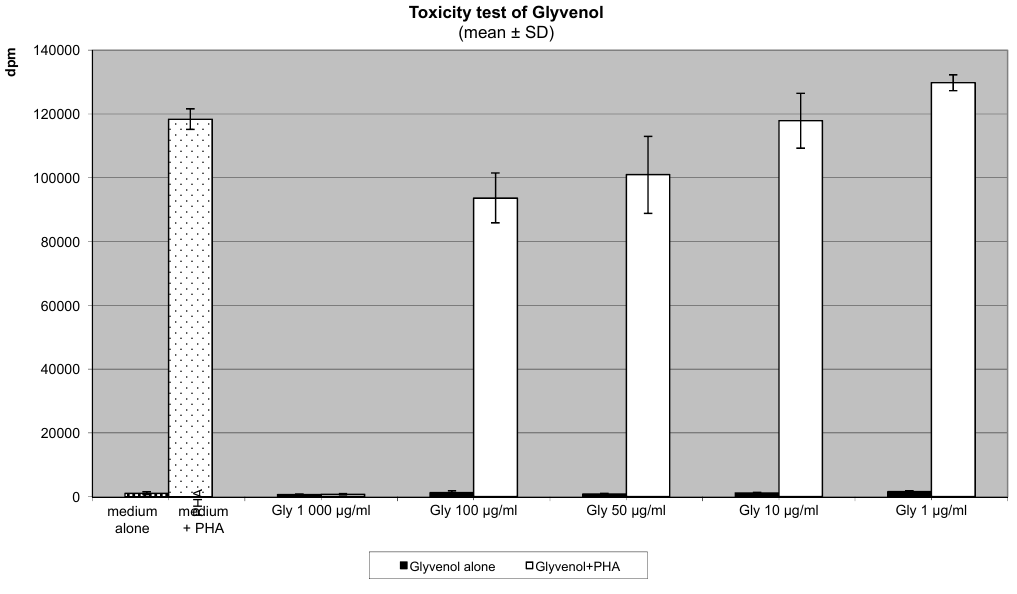
Figure 4. Toxicity test of Glyvenol. The relevant results of one of 4 non-allergic donors. The cell culture is measured in triplicates (mean ±SD) as described in Methods. PHA – phytohaemagglutinin, SD – standard deviation, dpm – disintegrations per minute.